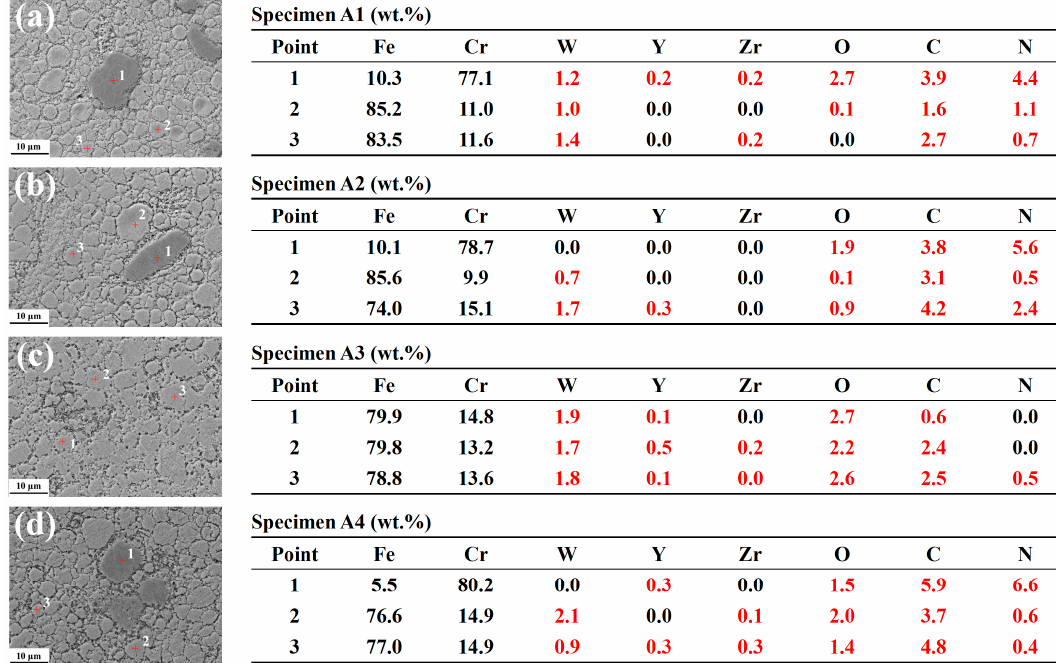
Figure 13. EDS results of sintered specimens: ( a ) A1, ( b ) A2, ( c ) A3, and ( d ) A4 (red results represent the inaccuracy).